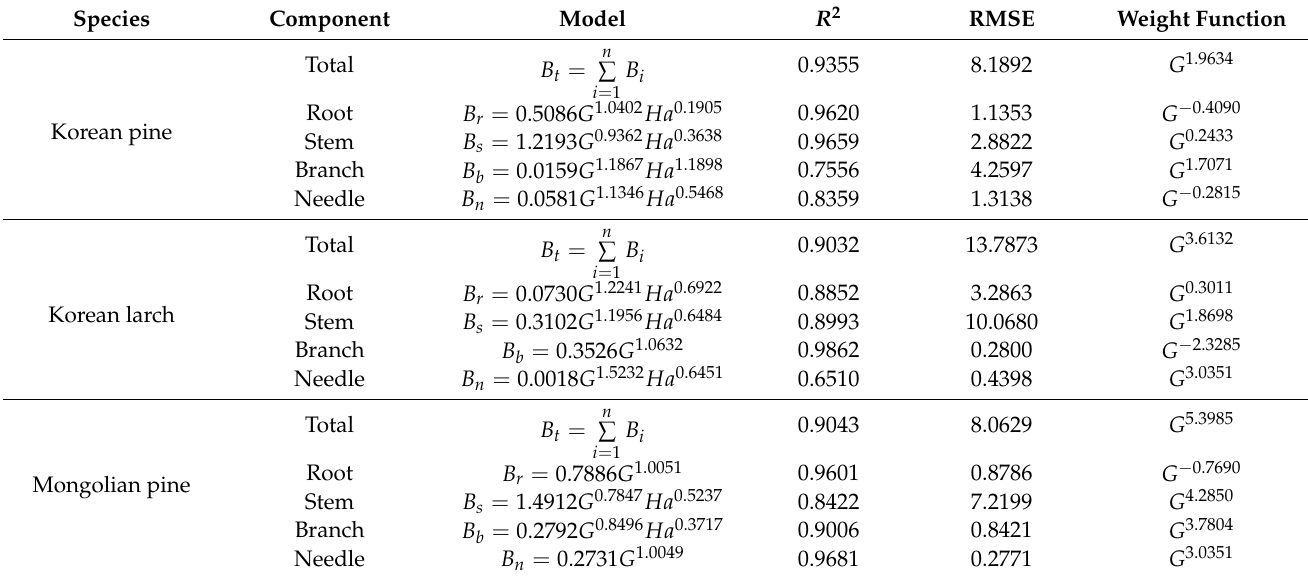
Table 3. Parameters and goodness-of-fit statistics of the BBMs and weight functions for three conifer